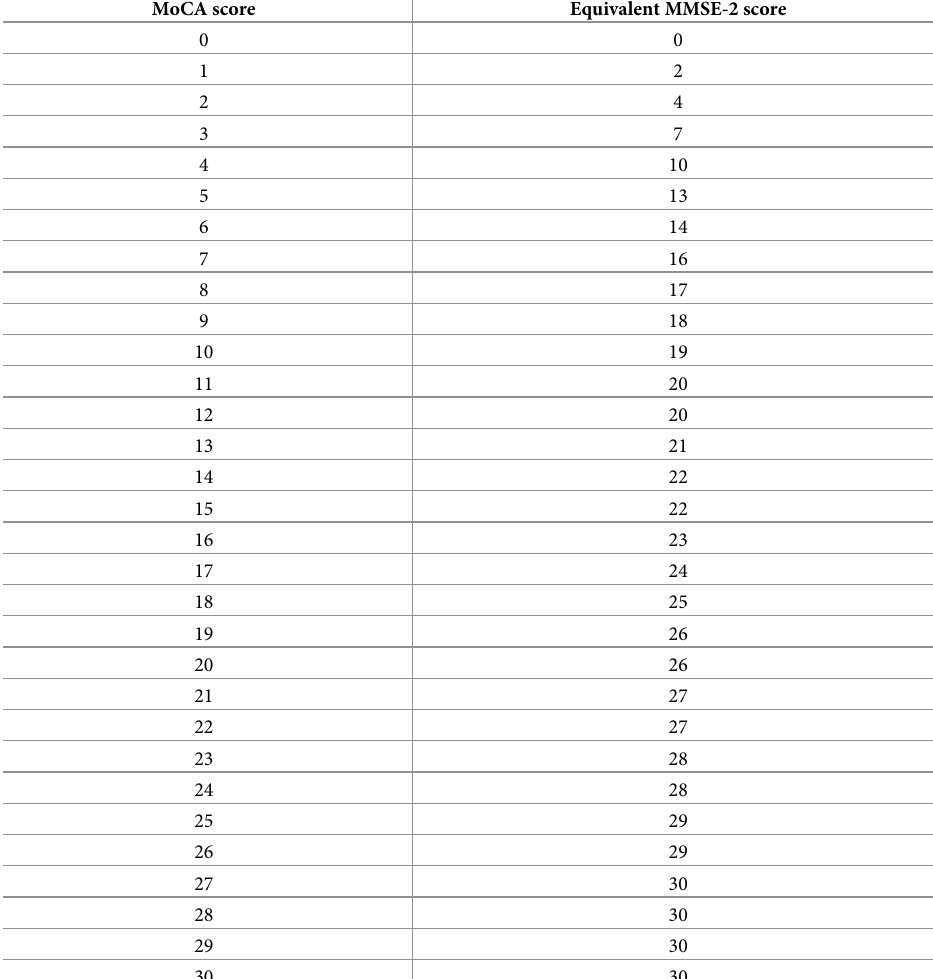
Abbreviations: MoCA, Montreal Cognitive Assessment; MMSE, Mini-Mental State